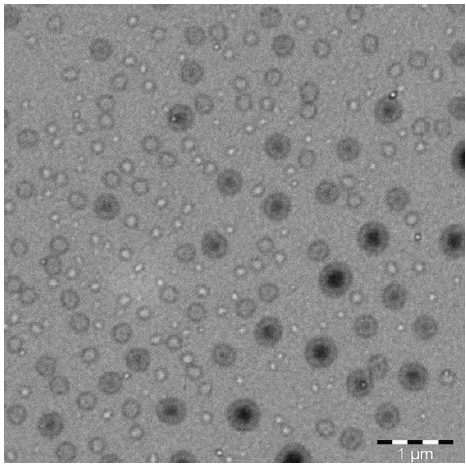
Figure 2. Transmission electron microscopy (TEM) for optimized SNEDDS F9 showing the droplets shape and size in submicron range.